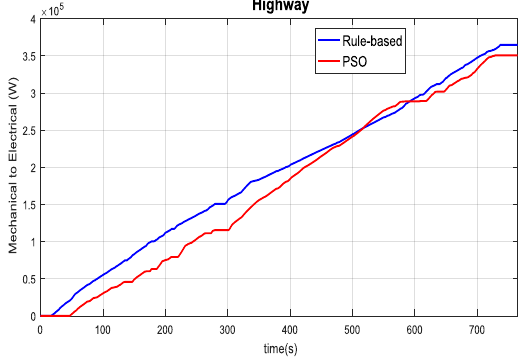
Figure 17. Comparison of electric conversion loss in the highway driving cycle.